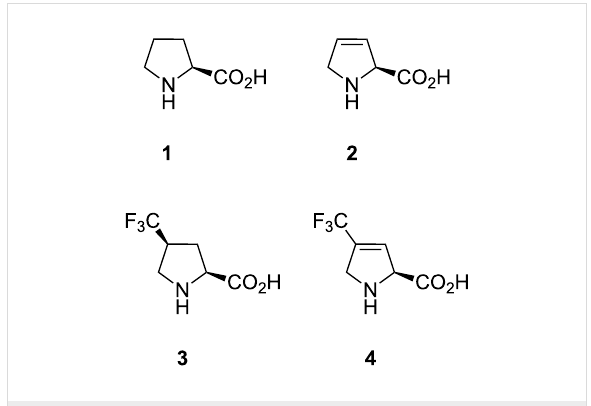
Figure 1: Amino acids that have been compared in this